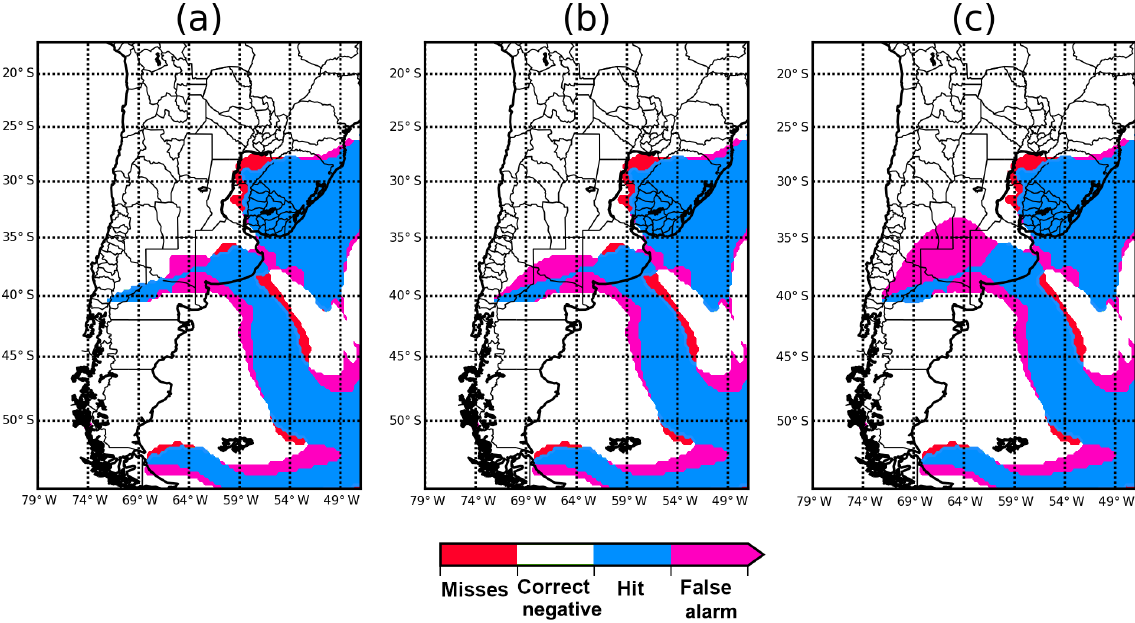
Figure 14. Ash mass loading above 0.2gm − 2 comparison between the ensemble mean optimized parameter run, the 12h forecast, and the 24h forecast against the nature run over a larger domain, verifying on 8 June at 00:00UTC (see the text for